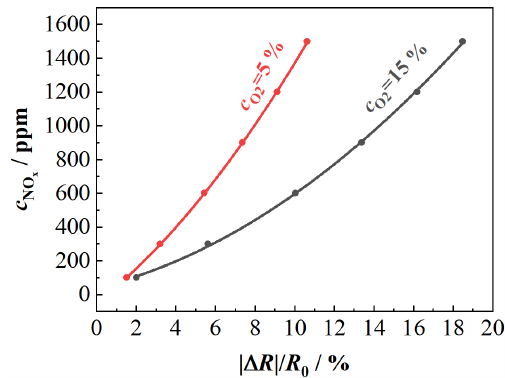
Figure 7. NO characteristic curve of the NO-sensitive layer for dif- ferent oxygen concentrations; sensor temperature: 650 ◦ C; compo- sition 1: 15% O 2 , 3% CO 2 , 3% H 2 O balanced by N 2 ; composi- tion 2: 5% O 2 , 8% CO 2 , 8% H 2 O balanced by N 2 ; NO variation: 100, 300, 600, 900, 1200, 1500ppm.